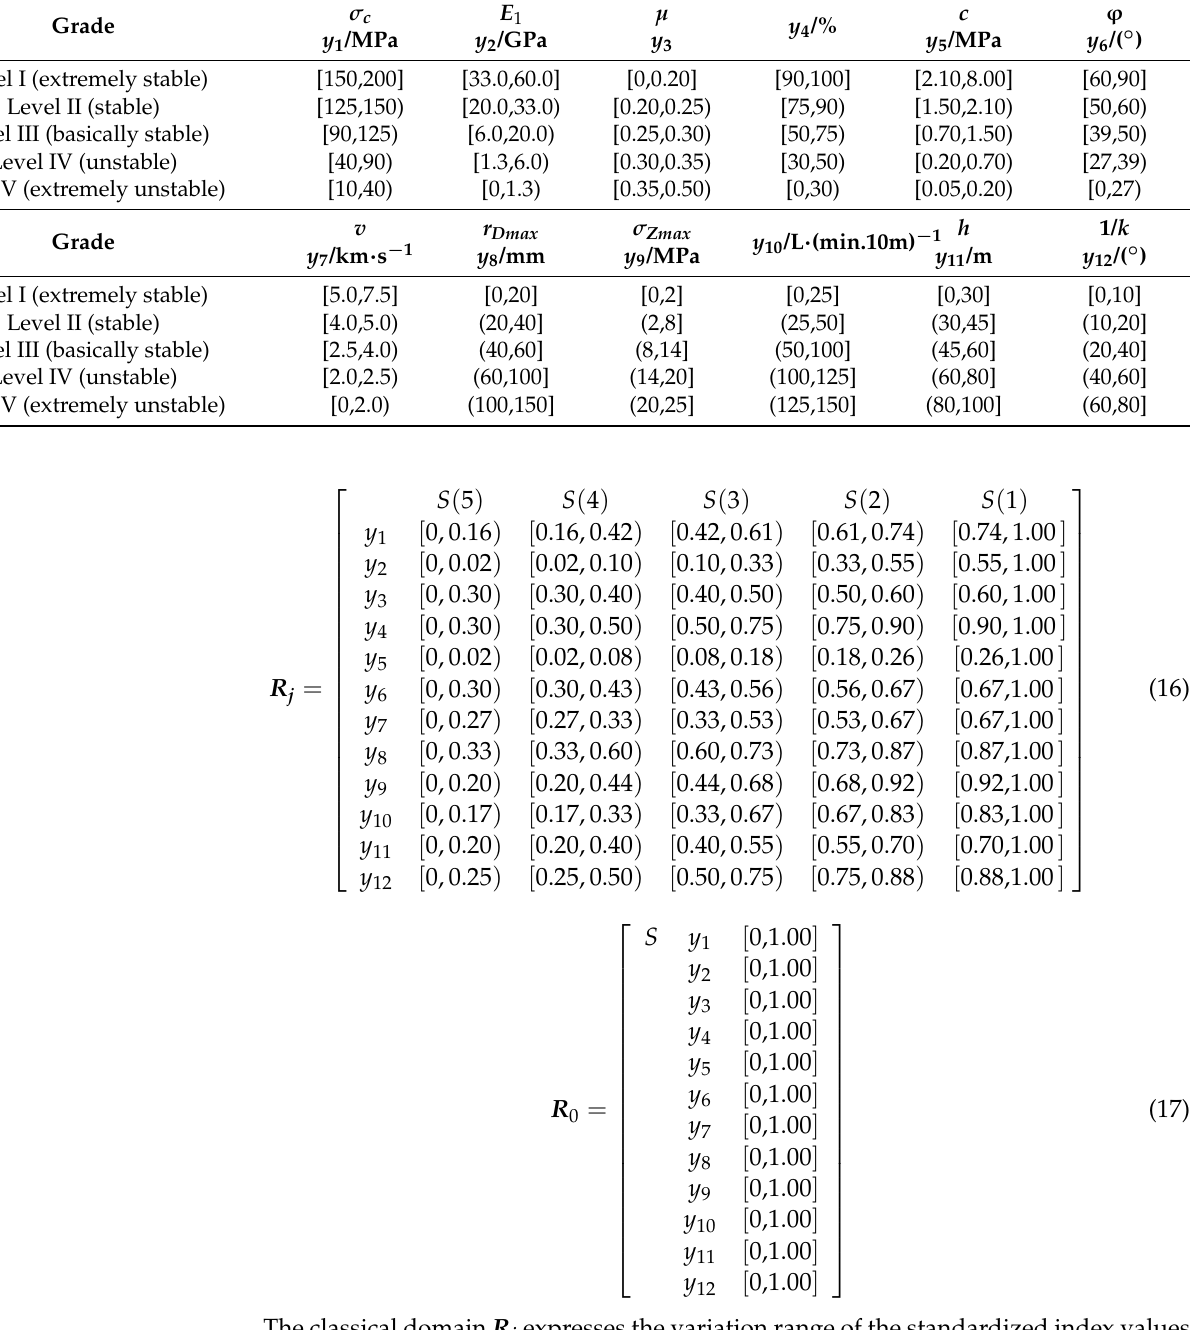
Table 1. Evaluation index classification criteria of the slope rock mass